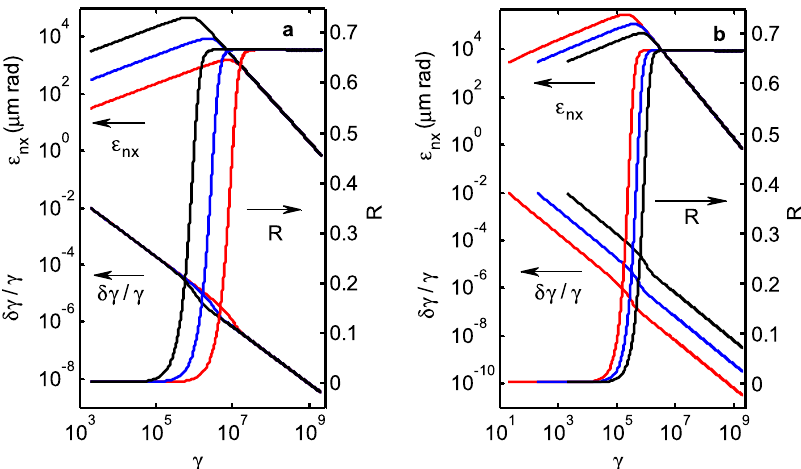
FIG. 2. Evolutions of normalized transverse emittances " , energy spreads (cid:11)(cid:8)=(cid:8) , and relative radiation loss rate R of electron nx beams (a) with different initial transverse emittances of 3000 (cid:4) m (black line), 300 (cid:4) m (blue line), and 30 (cid:4) m (red line), respectively, and (b) with different initial energies of 10 MeV (red lines), 100 MeV (blue lines), and 1 GeV (black lines), respectively, as a function of the beam energy (cid:8) . For all cases, other parameters are the same as those of Fig. 1. ¼ (cid:1) k =E r= 4 . The from the radial plasma current B (cid:16) EM p 0 (cid:1) B ¼ total focusing field on a beam electron is E r (cid:16) ð 1 = 2 Þ mc 2 k 2 r . Thus, the focusing constant is K ¼ k = p p